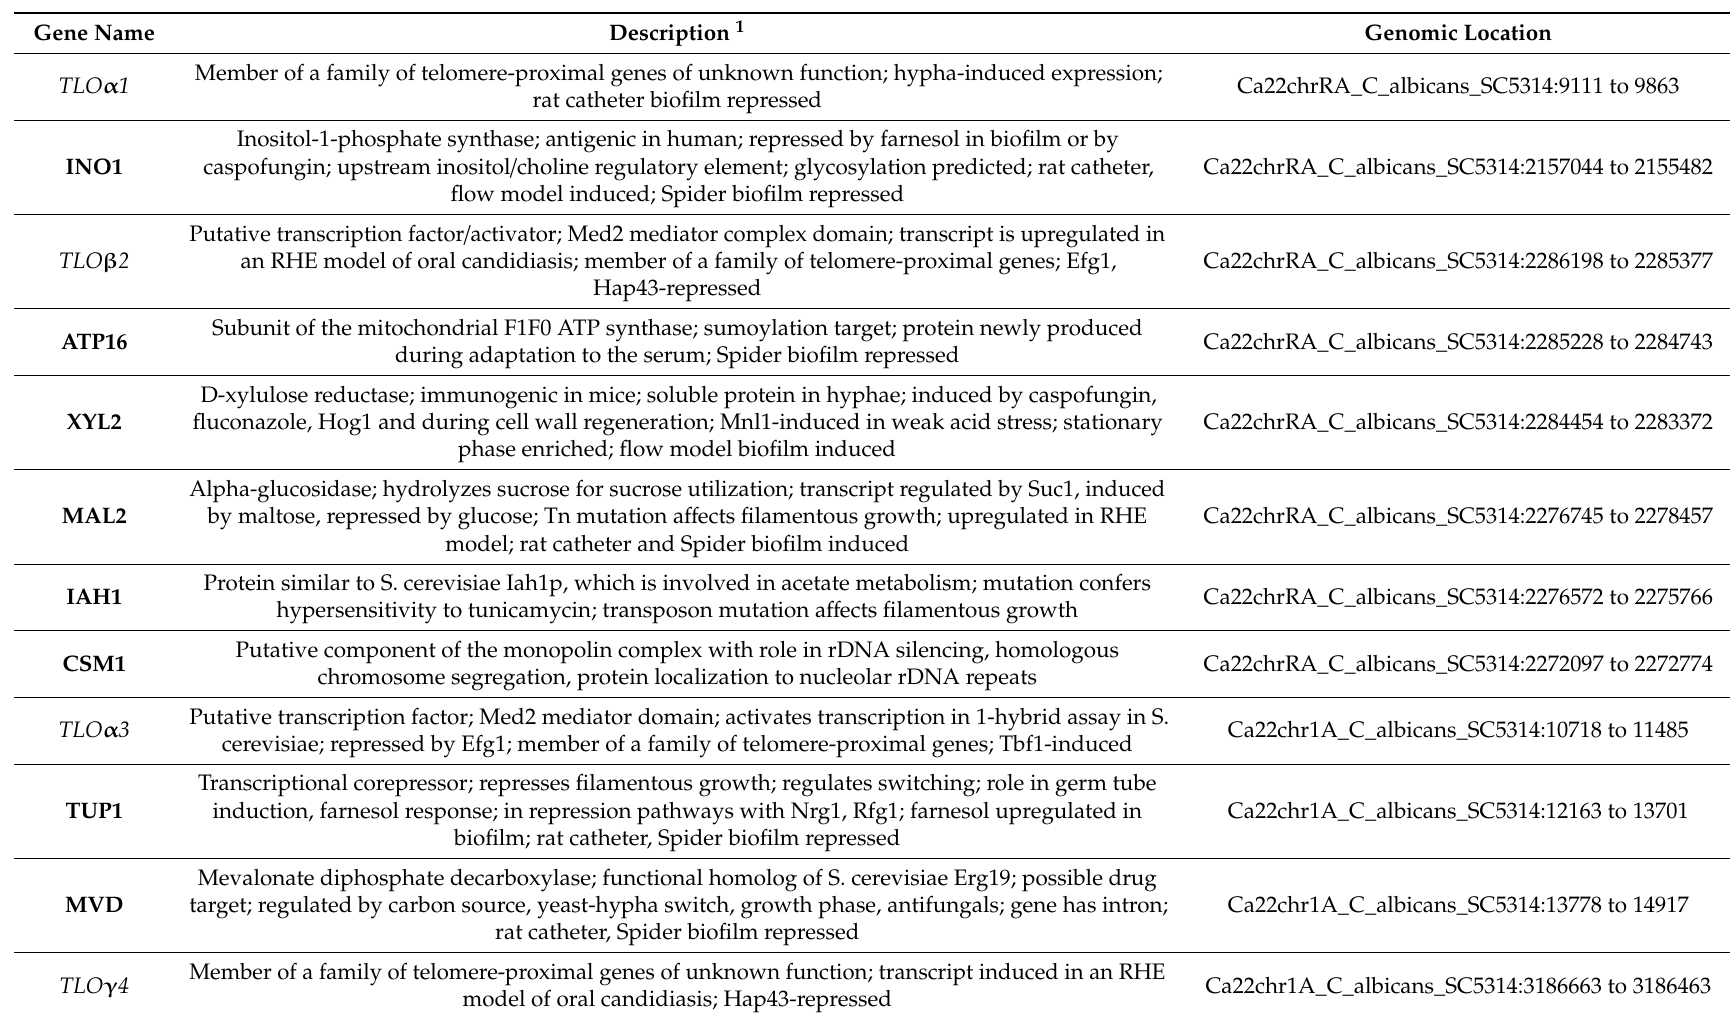
Table 2. C. albicans characterized subtelomeric